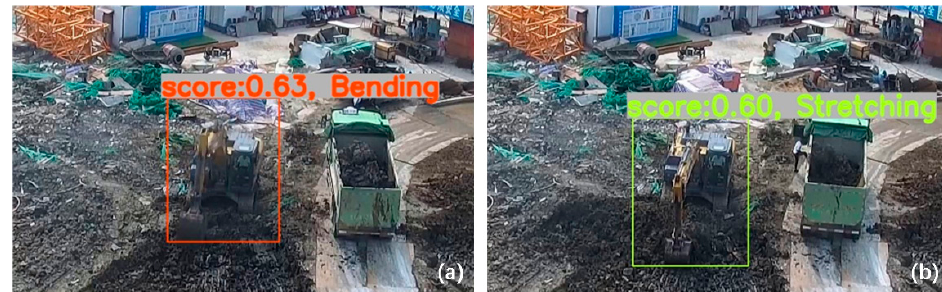
Figure 7. Wrong atomic action recognition. ( a ) “Stretching” is recognized incorrectly as “Bending”; ( b ) “Bending” is recognized incorrectly as “Stretching”.